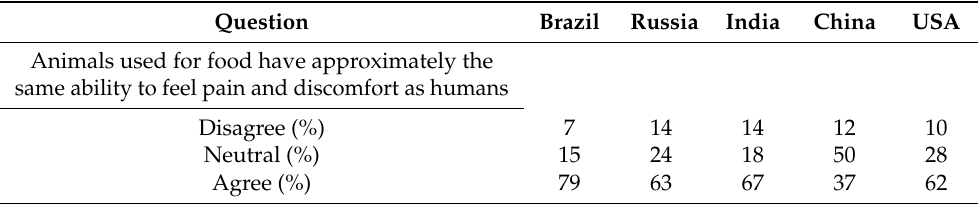
Table 1. Percentage of respondents to the question in each of the countries in each of the catego- ries disagree, neutral and agree.